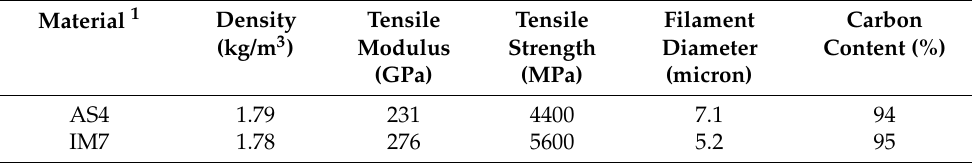
Table 1. Reinforcement materials employed in H2 cowling and aileron main beam.